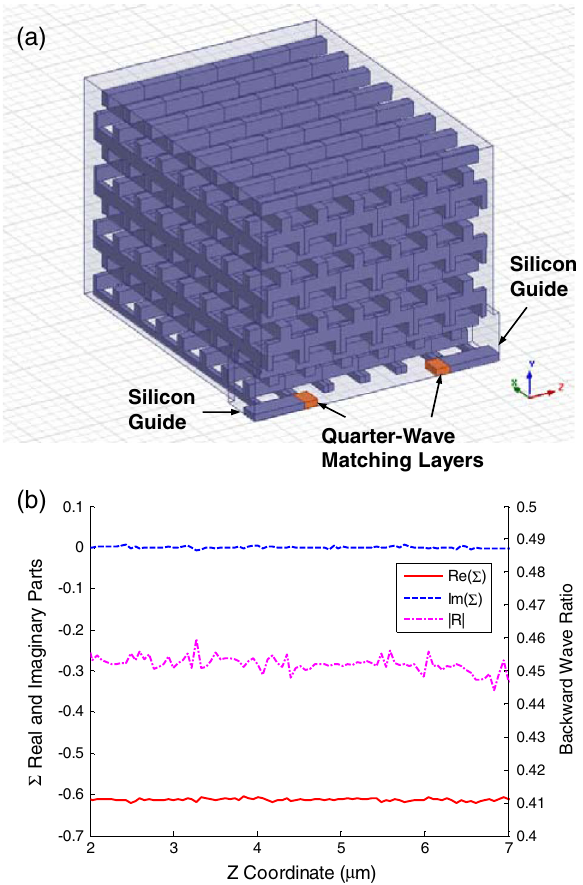
FIG. 2. (a) A TE-mode silicon woodpile waveguide excited by back-to-back silicon guide couplers. (b) Calculated Σ ð z Þ and the normalized backward wave amplitude j R j in this woodpile